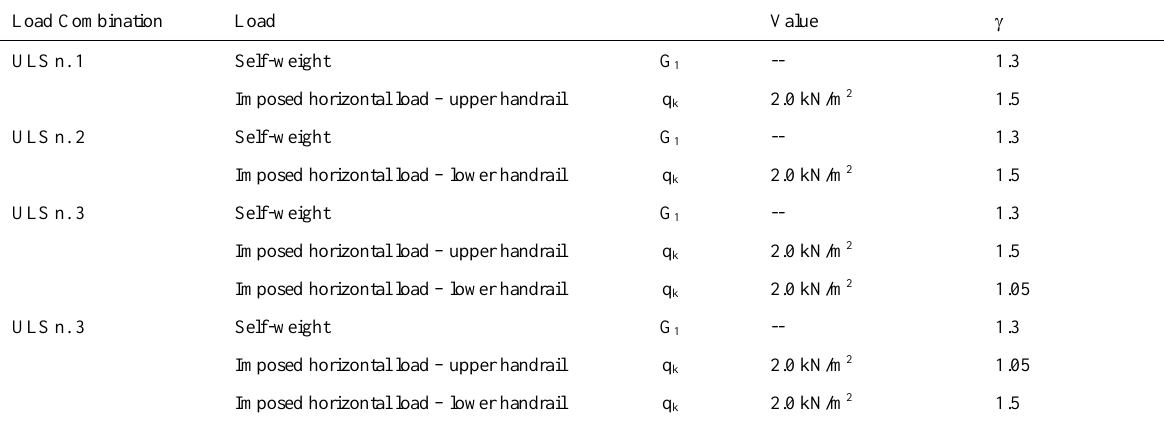
Table 5: ULS Load